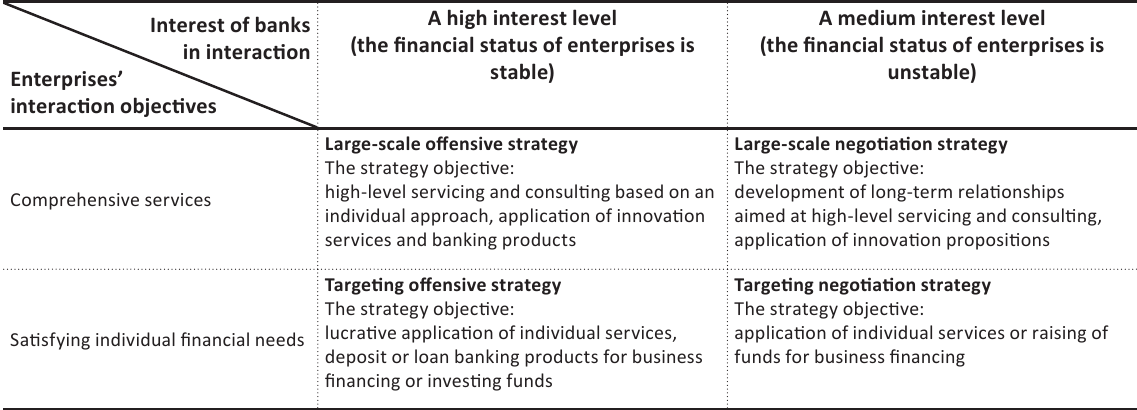
Source: Elaborated by the